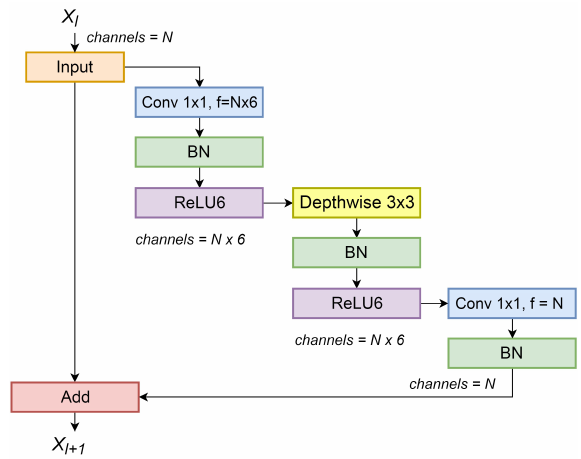
Figure 5. Inverted residual unit (IRU) used in our proposed network. It uses regular 1 × 1 convolutions (“Conv”), 3 × 3 depthwise convolutions, batch normalization (“BN”) and Rectified Linear Unit activation with a maximum possible value of 6